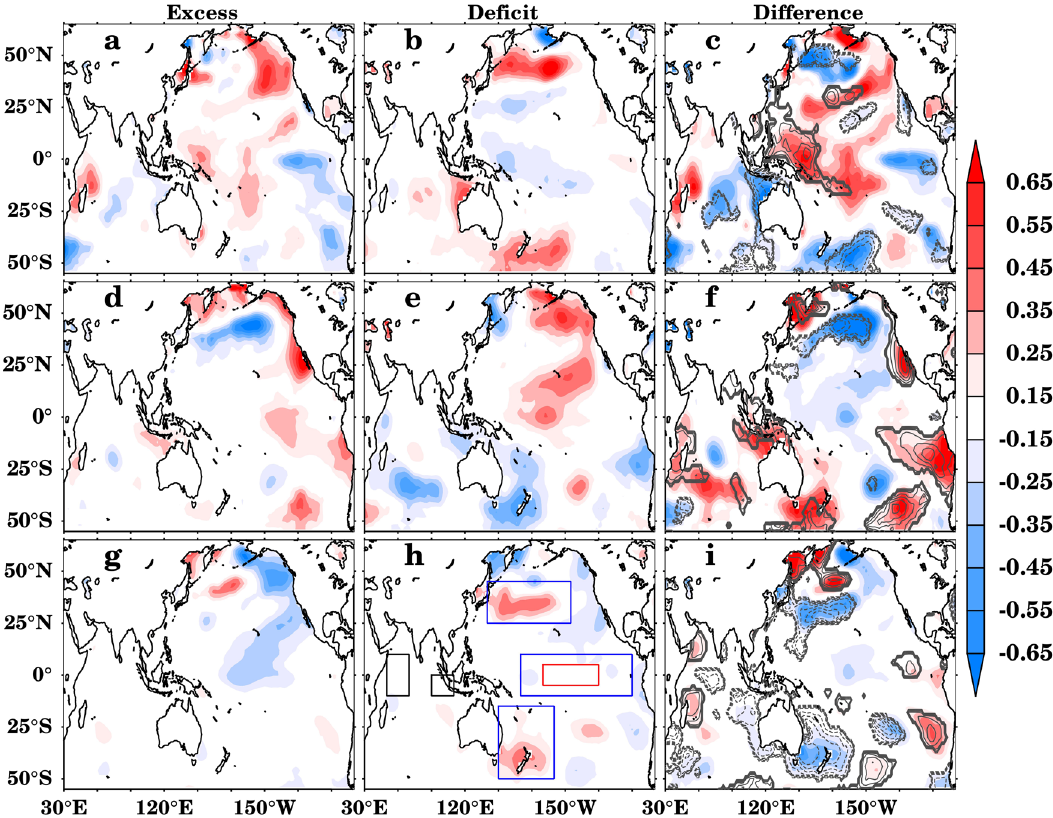
Fig. 4 Teleconnection of WG rainfall variability to Indo-Paci fi c SST. Composite of summer mean SSTA (°C) from ERSSTv5 for a excess, b de fi cit rainfall years and c difference ( a , b ) for period 1 (1901 – 1942). d , e , and f same as a , b , and c but for period 2 (1943 – 1977). g , h , and i same as a , b , and c but for period 3 (1978 – 2010). Contours in panels c , f , and i showing the correlation of fi ltered WGI with fi ltered SST at 90% con fi dence upon student t -test. Boxes in h are representing the area taken for calculating SST indices: Niño3.4 (red box), TPI (blue boxes), and DMI (black